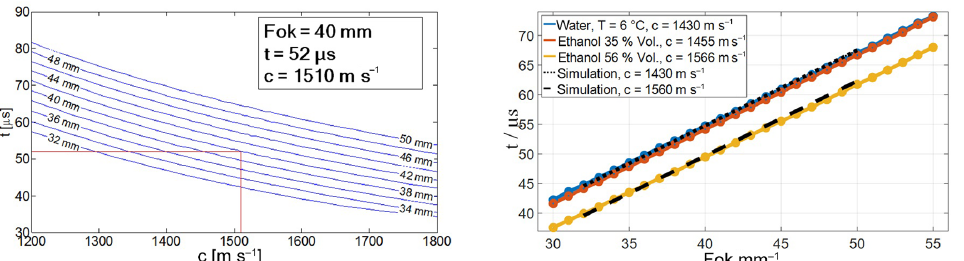
Figure 4. Left: calibration curve – time of flight as a function of sound velocity for different control modes; right: time of flight as a function of control mode for different sound velocities.